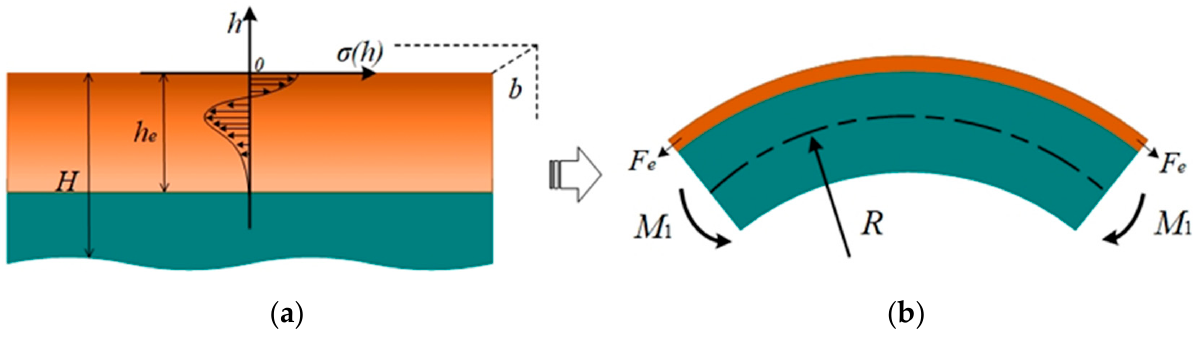
Figure 1. Machining residual stress on the surface and its equivalent bending moment. ( a ) residual stress on the machined surface; ( b ) equivalent bending moment .